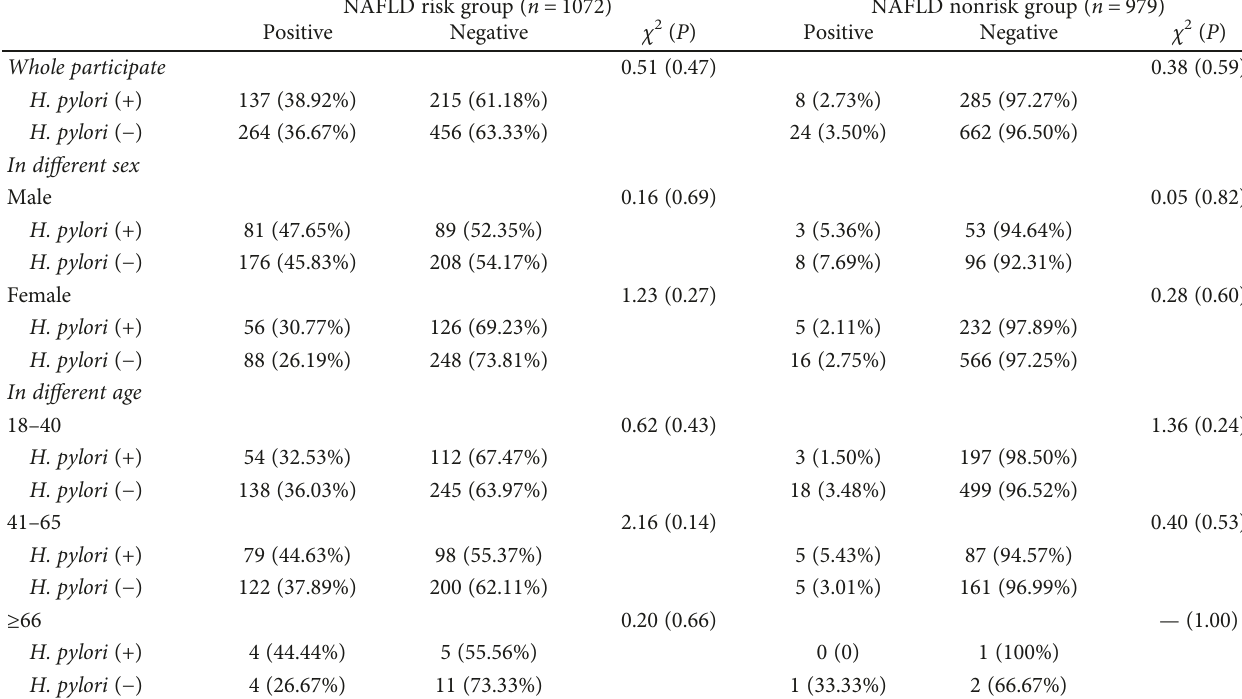
Table 4: Association analysis between H. pylori infection and